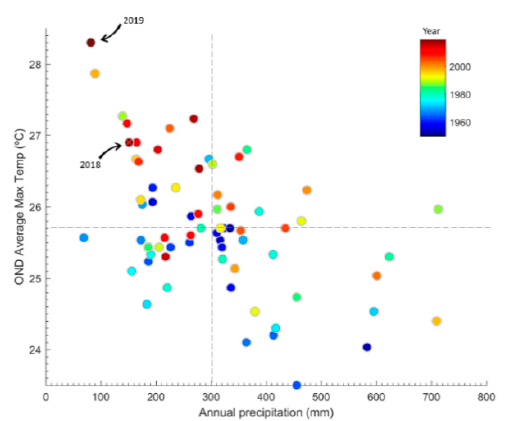
Figure A1. Relationship between total number of visits to flower-heads by hummingbirds including visits behind rocks (visits unconstrained) and the number based only on flower-head visits that could be easily seen (visits constrained). The data points are the sum of the visits recorded on the four plots per hour over each day (5) of the pollinator sampling (N = 60). The fine black line shows the 1:1 expectation.